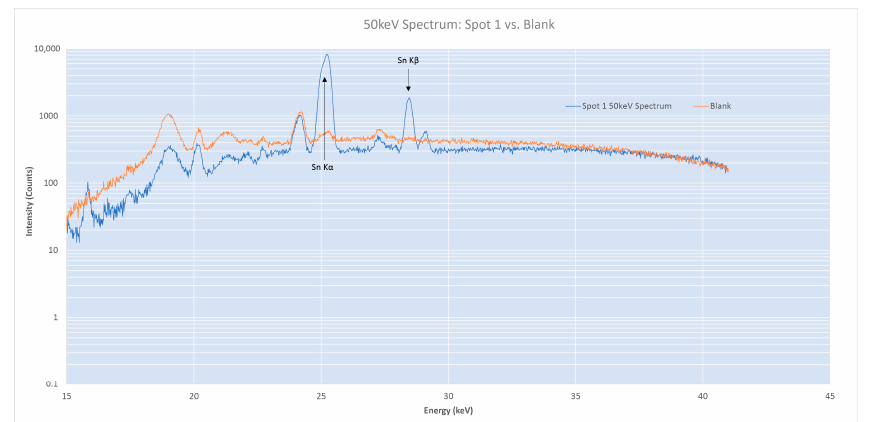
Figure 7. The 50 keV spectrum of spot 1 and of a blank. Highlighted is the energy of the X-ray emission of Sn: K α 1 25.2713 keV and K β 1 28.486 keV.